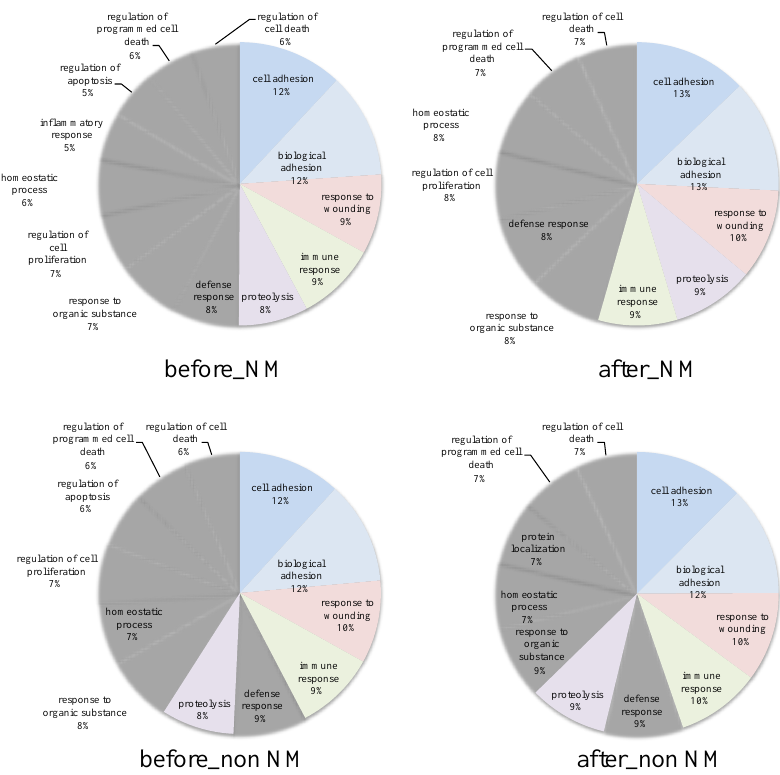
Figure 4. Circle graph showing biological processing from GO annotation. The top 5 biological processes were colored.